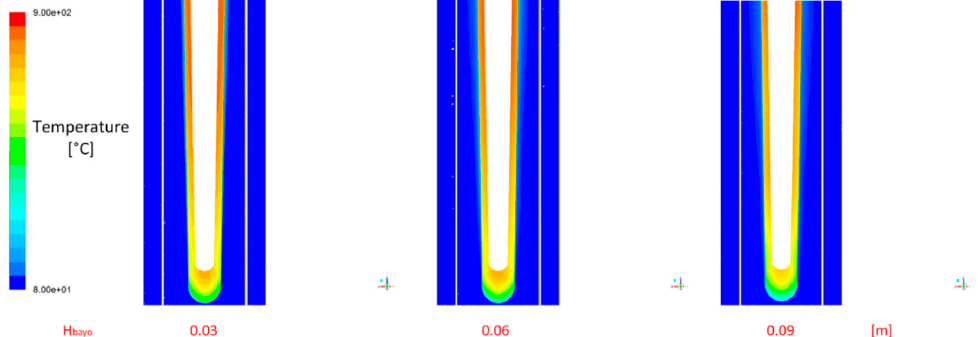
Figure 7. Comparison of temperature fields for H bayo equal to 0.03, 0.06 and 0.09 m.